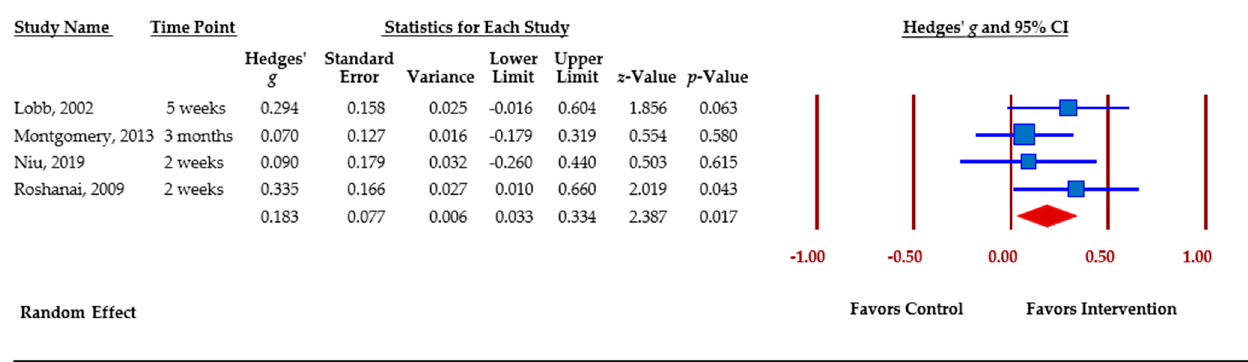
Figure 6. Depression.